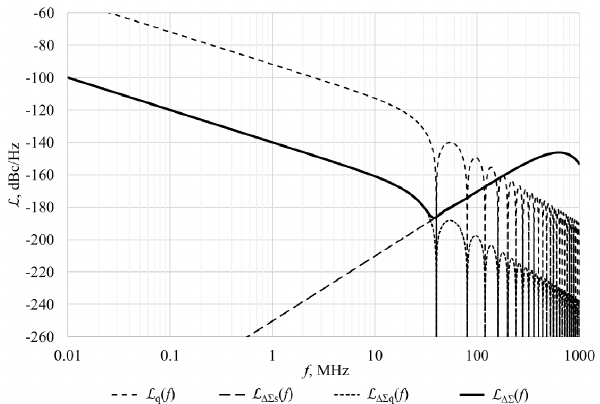
Figure 5. Calculated phase noise and its components, induced by quantization of digitally controlled oscillator, when f DCO = 6 GHz, f REF = 40 MHz, f ΔΣ = f DCO /4, Δ f RES = 560.64 kHz, W = 8, n = 3.